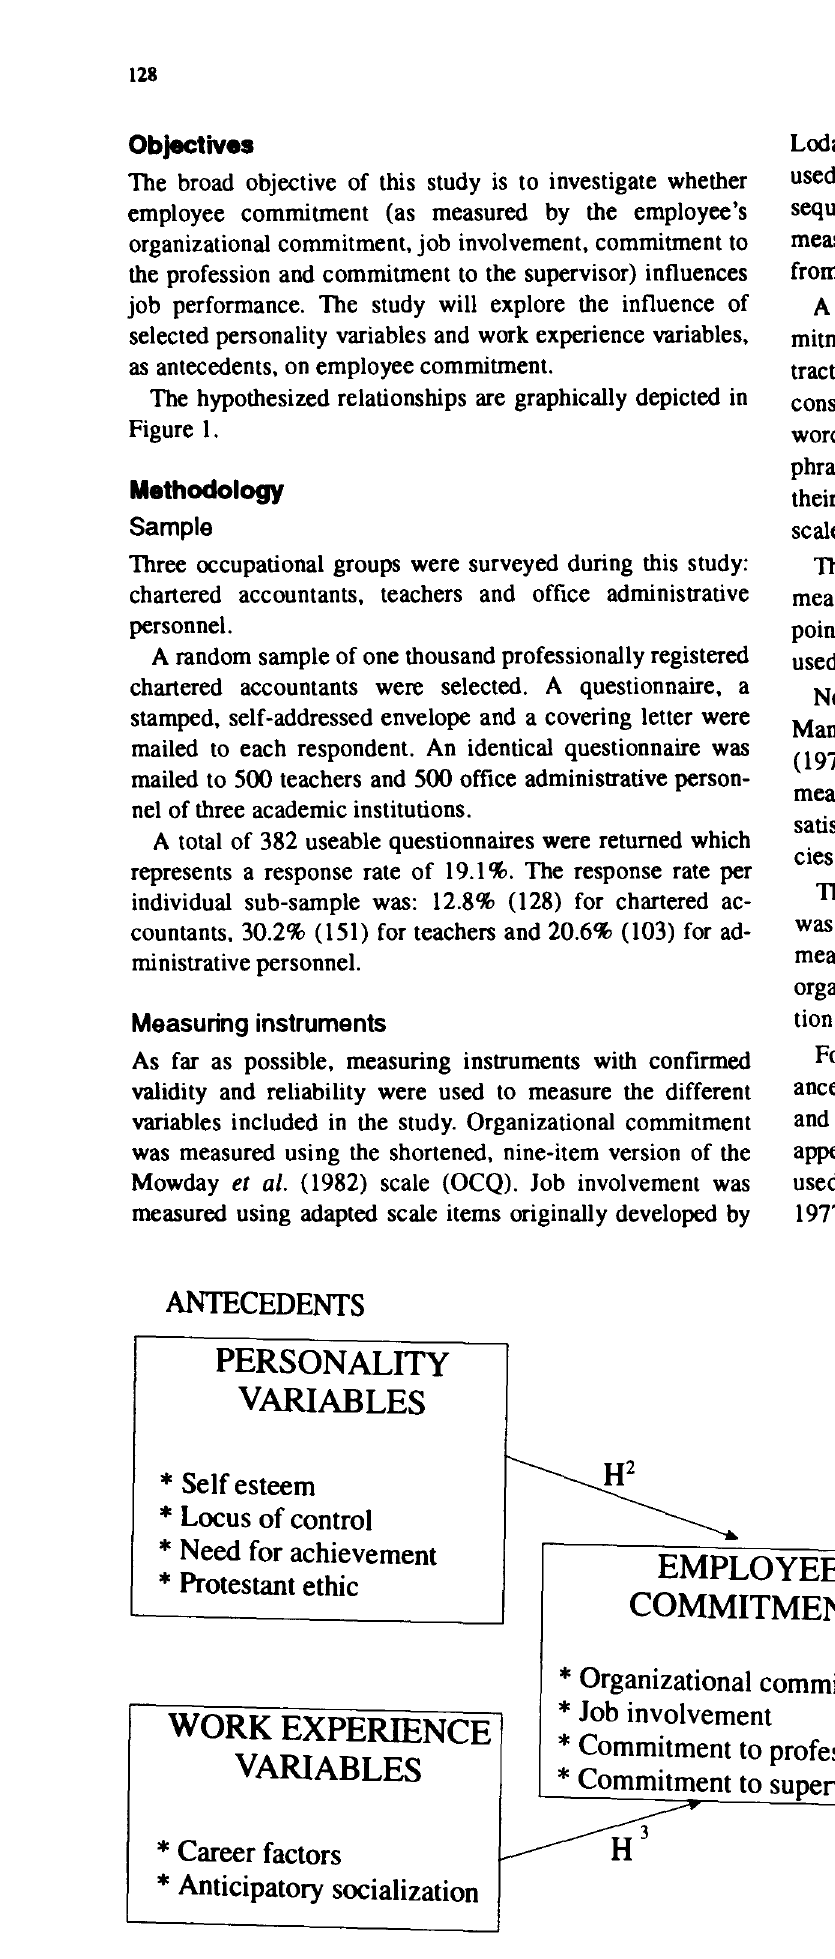
Figure 1 Hypothesized